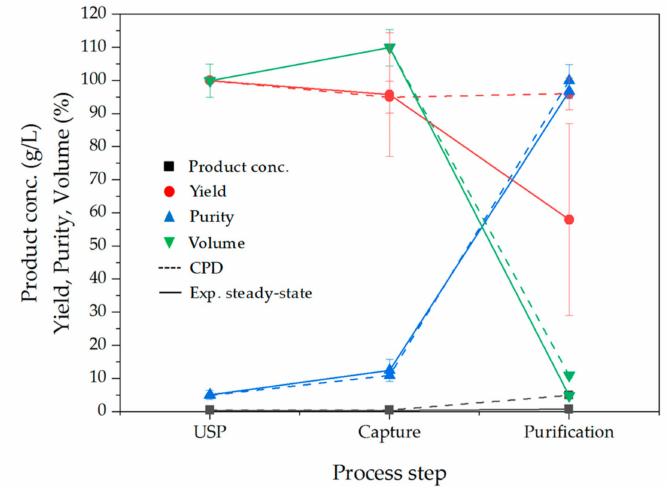
Figure 26. Comparison between conceptual process design (CPD, solid line, —) and steady-state experimental data (Exp., dashed line, —) in terms of product concentration (black, g / L), yield (red, %), product purity (blue, %), and volume (green, %). Purity is well met, only yield and product concentration di ff er due to described handling and modified product concentrations during cell cultivation. Error bars depict the double determination of each variable based on experimental data and uncertainties of the